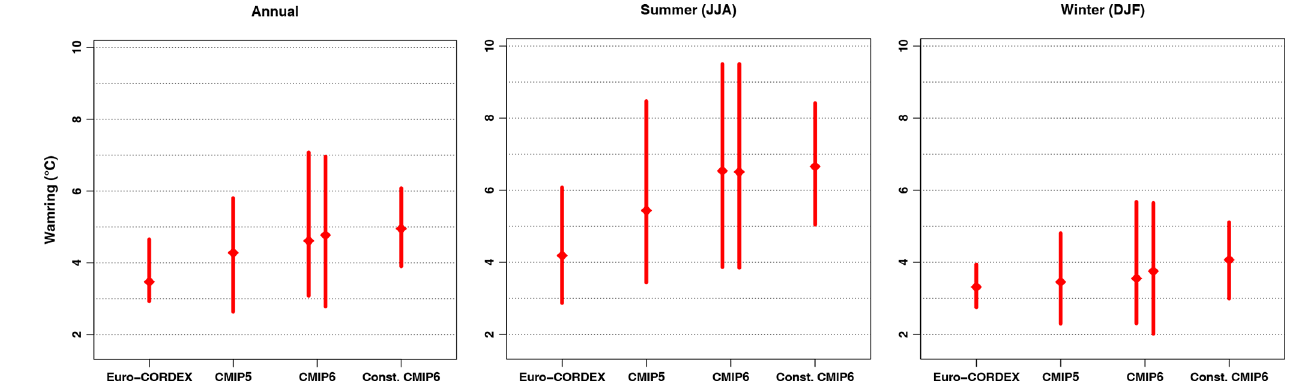
Figure 6. Forced warming estimates from various multi-model ensembles. The constrained CMIP6 ranges of mean temperature change are compared to those from the EURO-CORDEX, CMIP5, and CMIP6 ensembles (all unconstrained). The comparison is made for the 2070–2098 vs. 1971–2000 warming (periods that are covered by all model experiments) in the RCP8.5 (EURO-CORDEX and CMIP5) or SSP5-8.5 (CMIP6) scenarios. All confidence ranges are 5%–95% ranges, with the median used as a central estimate. The two CMIP6 ranges are derived with and without assuming a Gaussian distribution: on the left, quantiles are directly estimated from the sample of CMIP6 models (consistent with EURO-CORDEX and CMIP5); on the right, a Gaussian distribution is assumed for that sample (consistent with the prior used in the observational